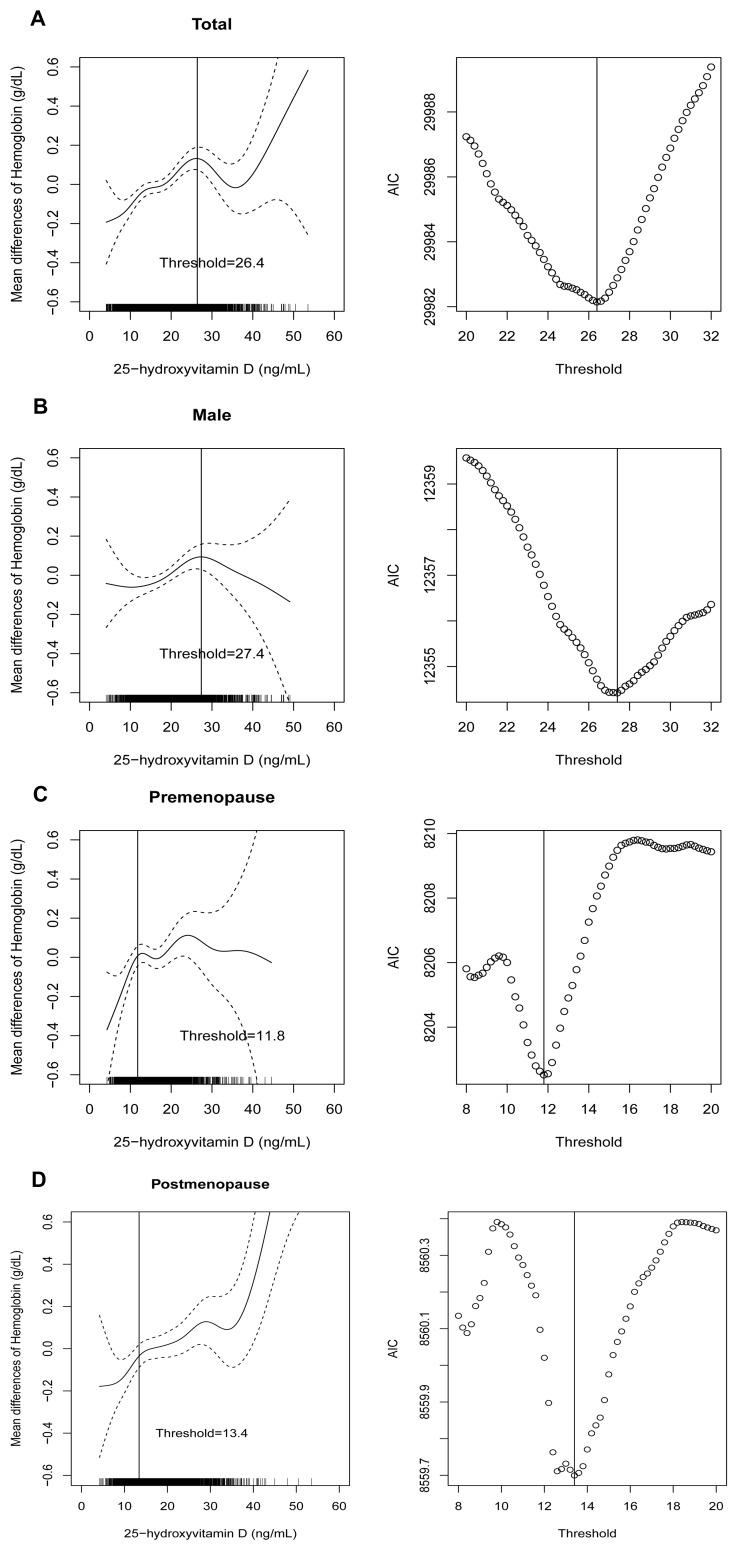
Spline curve (solid line) with 95% confidence intervals (two dashed lines) using generalized additive model for Gaussian distribution and process of determining the threshold level for an association using Akaike’s information criterion.Total subjects (A), males (B), premenopausal females (C), and postmenopausal females (D). AIC, Akaike’s information criterion.